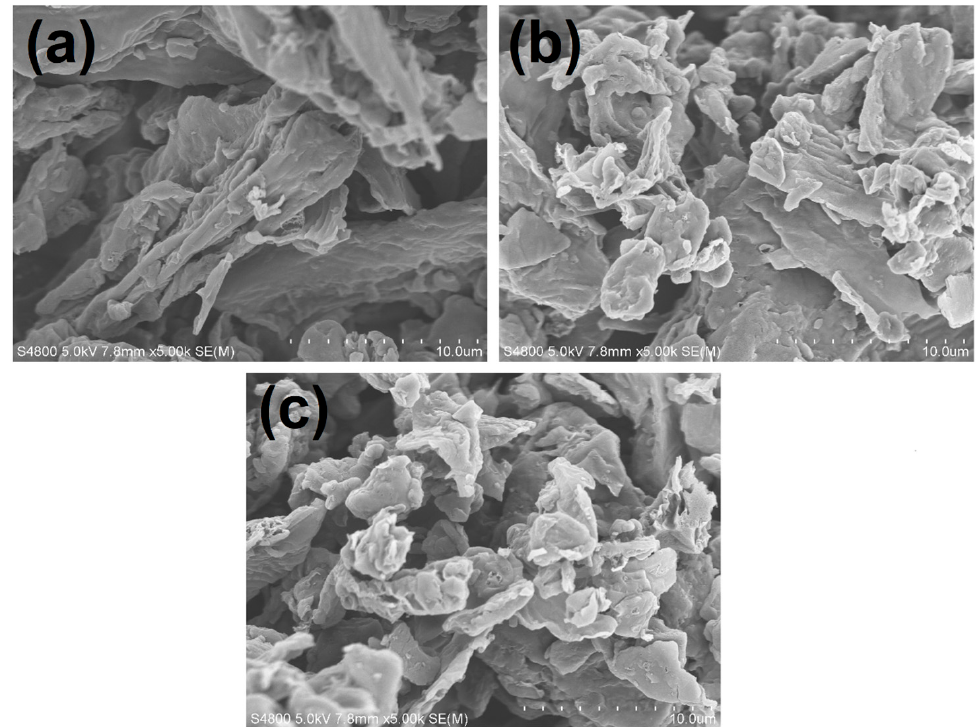
Figure 1. SEM images of lotus leaves at different pyrolysis temperatures (( a ): 700 °C, ( b ): 800 °C, ( c ): 900 °C). Table 1. Elemental content and pore characteristics of lotus leaf-based biochar at different pyrolysis